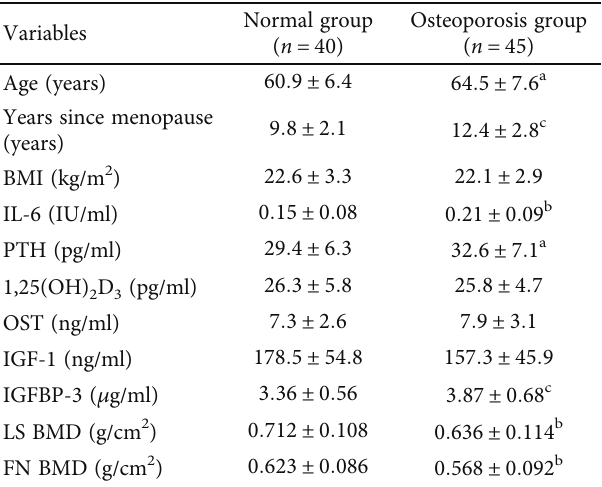
Table 1: The demographics and baseline data of the participants in the normal group and osteoporosis group (mean and standard